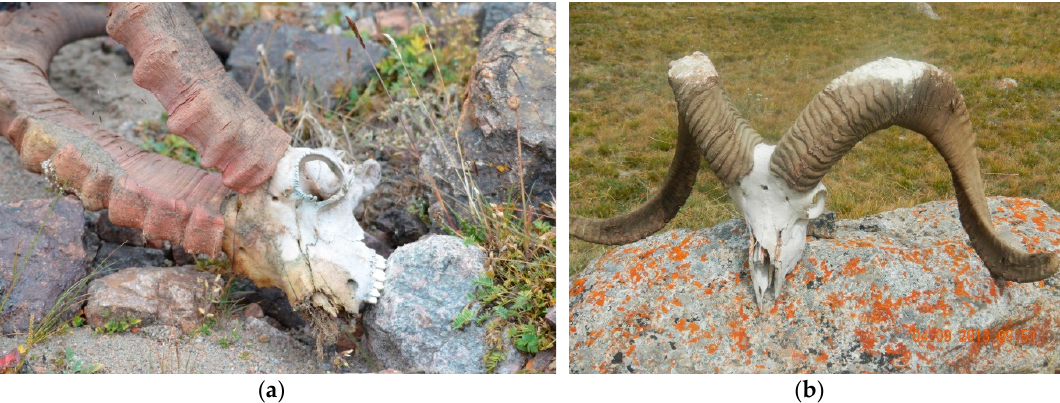
Figure 1. Bones contain useful information on some metal contamination in the mountains. Hundreds of ( a ) Asiatic ibex and ( b ) Marco Polo sheep skulls may be found in the valleys of Kyrgyzstan. The animals are hunted by local people for meat and heavy heads are usually left in the field. Photo: M. Janiga, 2013.